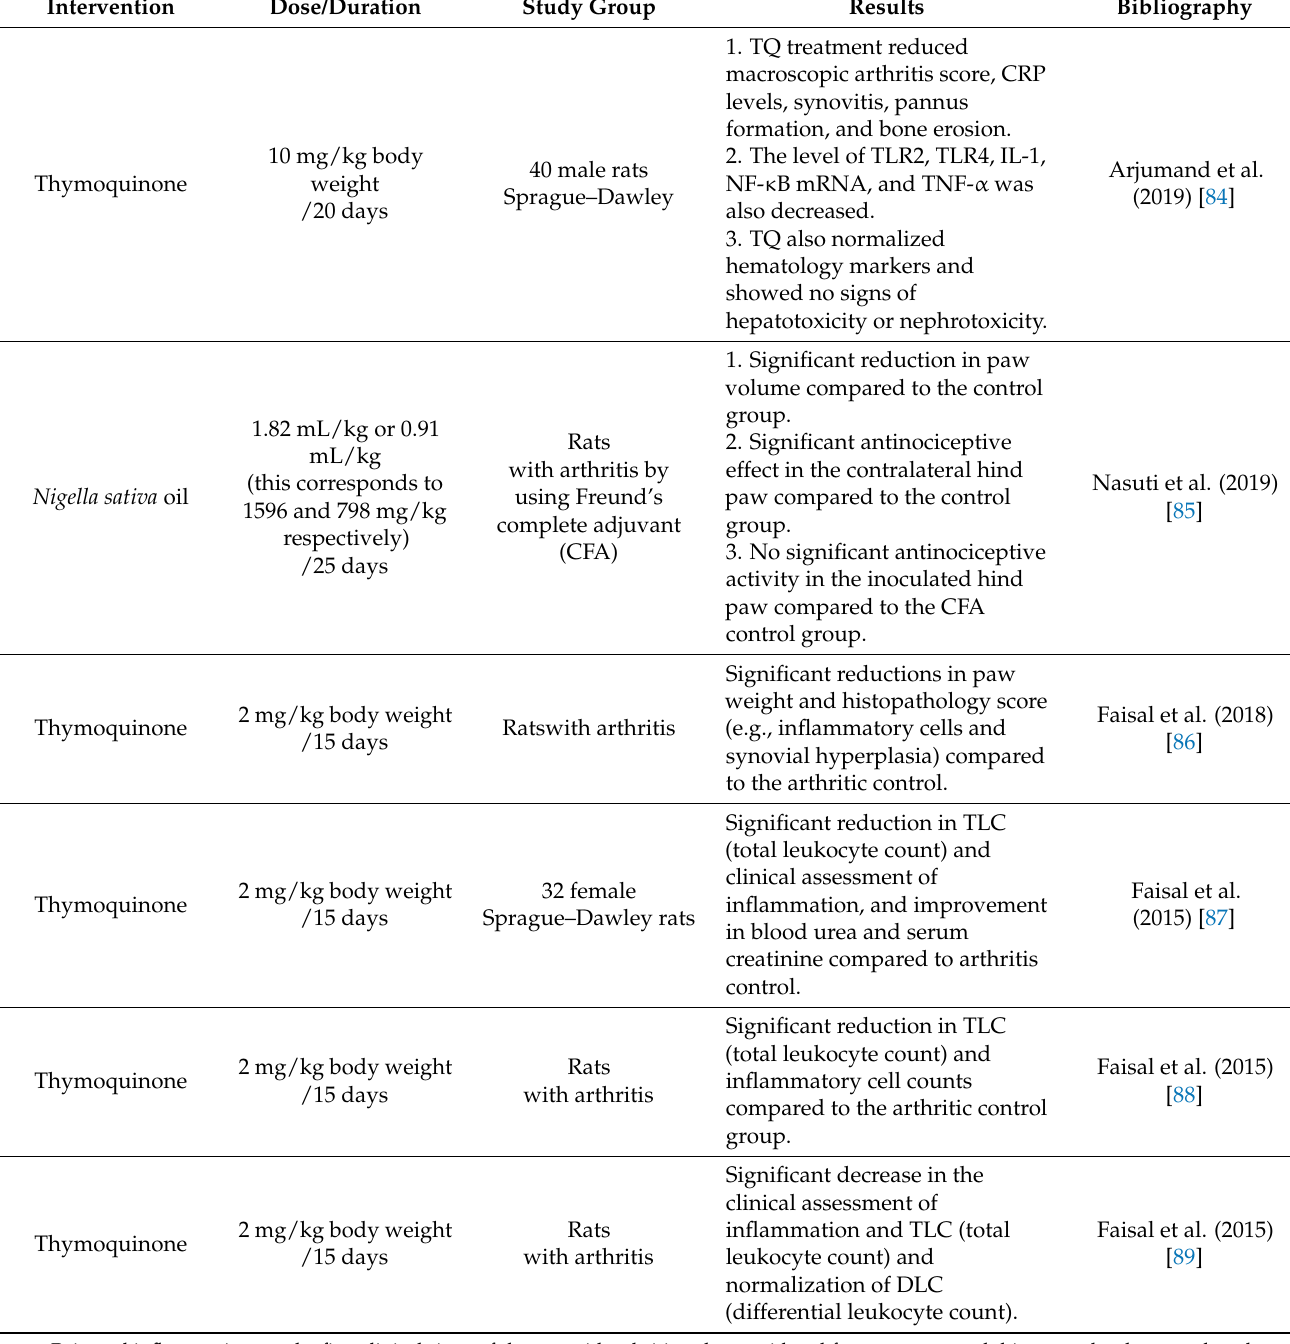
Table 3. Characteristics of animal studies of the effects of Nigella sativa on rheumatoid